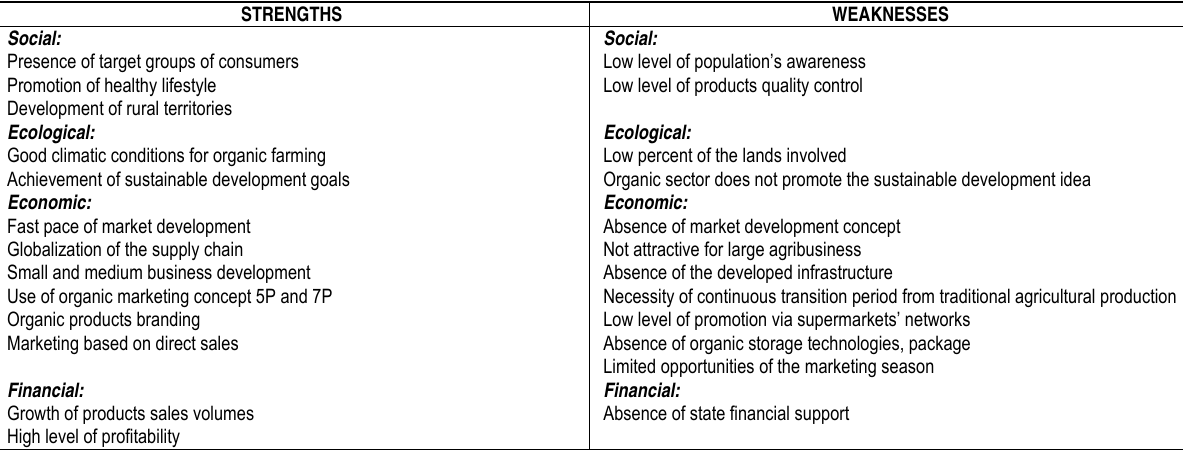
Table 1. Results of the SWOT analysis of the Ukrainian organic products market